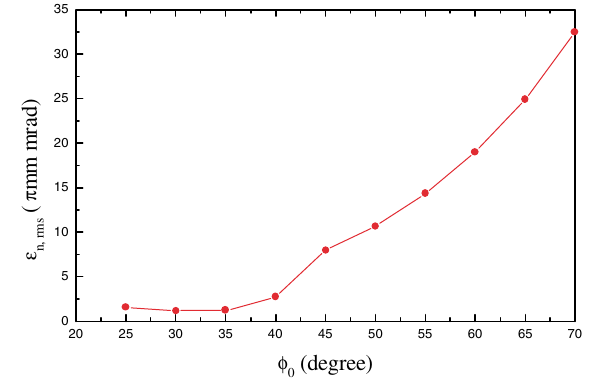
FIG. 5. (Color) Normalized transverse rms emittance vs rf phase at cathode.